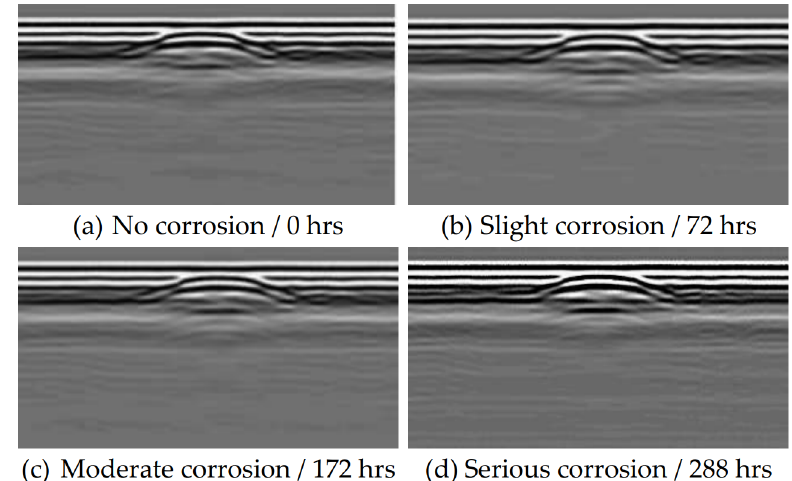
Figure 9. GPR Scanning Profile of Steel Bar Corrosion (thickness of 4 cm).